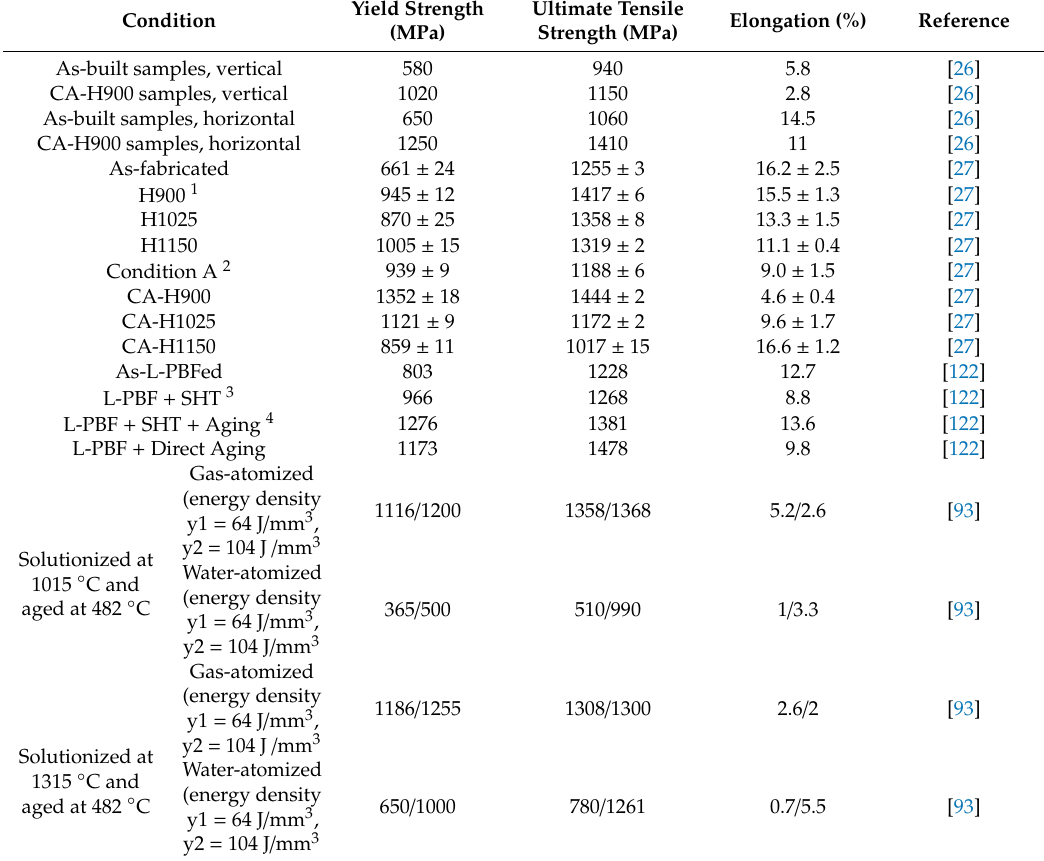
Table 8. The e ff ect of heat treatments on the mechanical properties (material: 17–4 steel).